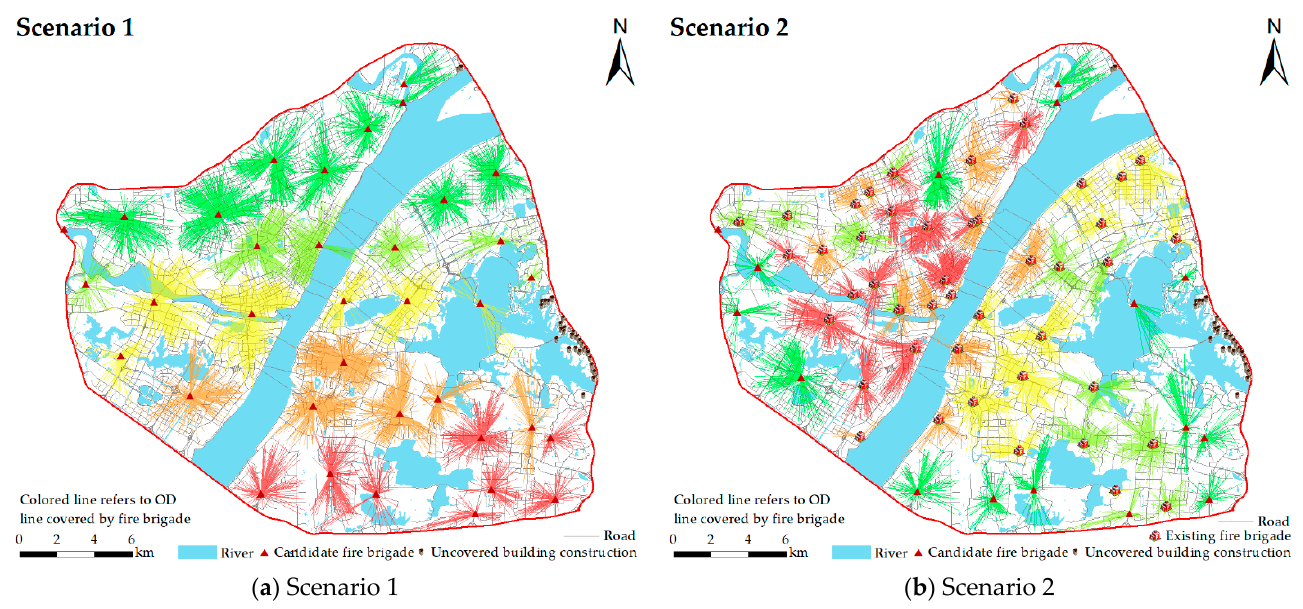
Figure 14. Minimum facilities coverage problem for existing fire brigades in idealized case.